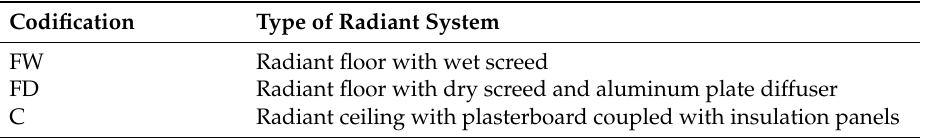
Figure 3. Description of the radiant systems considered in this work. Table 3. Codification of the three types of radiant systems.